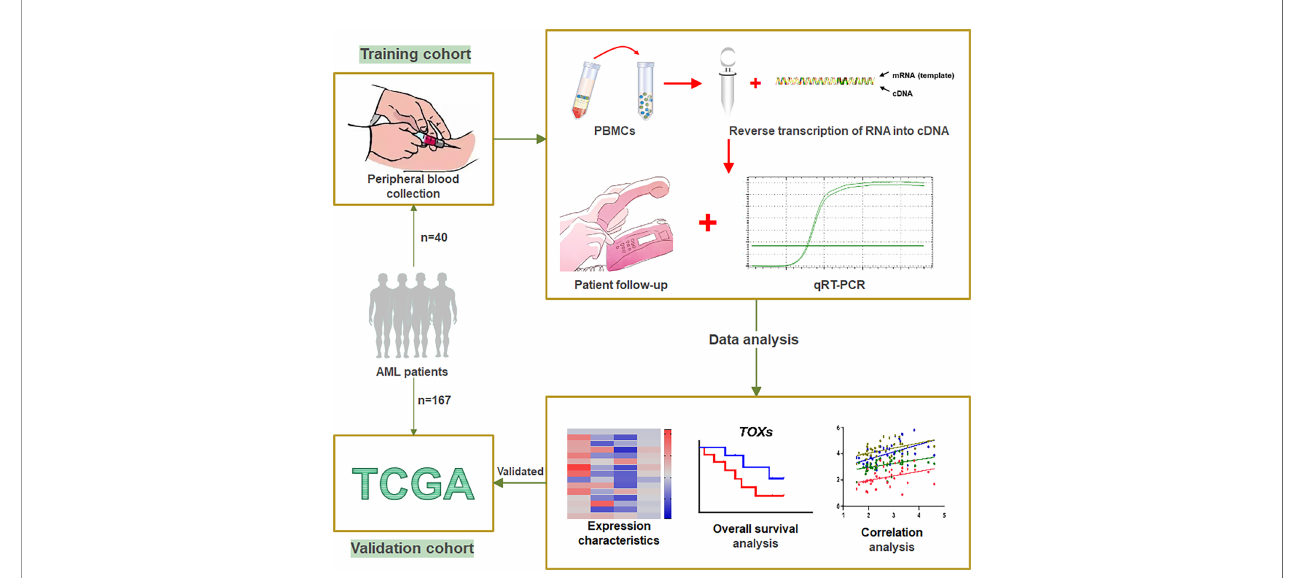
FIGURE 1 | Work fl ow of study. A total of 40 AML patients from our clinical center were designated as the training cohort. Peripheral blood was collected from these patients to obtain PBMCs, which were used to translate RNA into cDNA. qRT-PCR was used to detect the expression levels of the TOX genes and ICs . After patient follow-up, the data were analyzed by expression characteristics, overall survival analysis, and correlation analysis. The gene expression data and clinical information of 167 de novo AML patients obtained from the TCGA were designated as a validation cohort. PBMCs, peripheral blood mononuclear cells; ICs, immune checkpoint genes; qRT-PCR, Quantitative Real-Time PCR; TCGA, The Cancer Genome